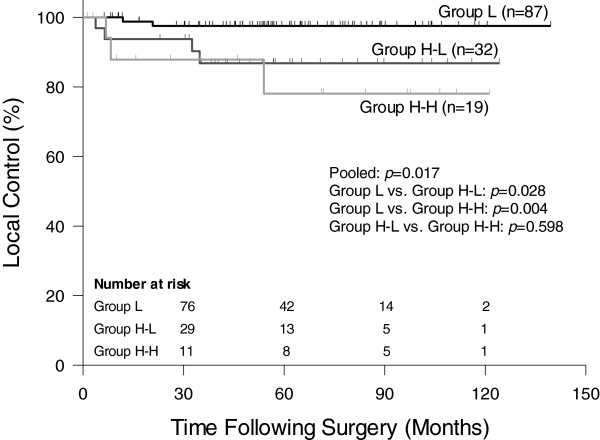
Comparison of local control between group L, H-L and H-H. Group L: pre-CRT CEA <6 ng/ml; Group H-L: pre-CRT CEA ≥6 ng/ml and post-CRT CEA <6 ng/ml; Group H-H: both pre- and post-CRT CEA ≥6 ng/ml.